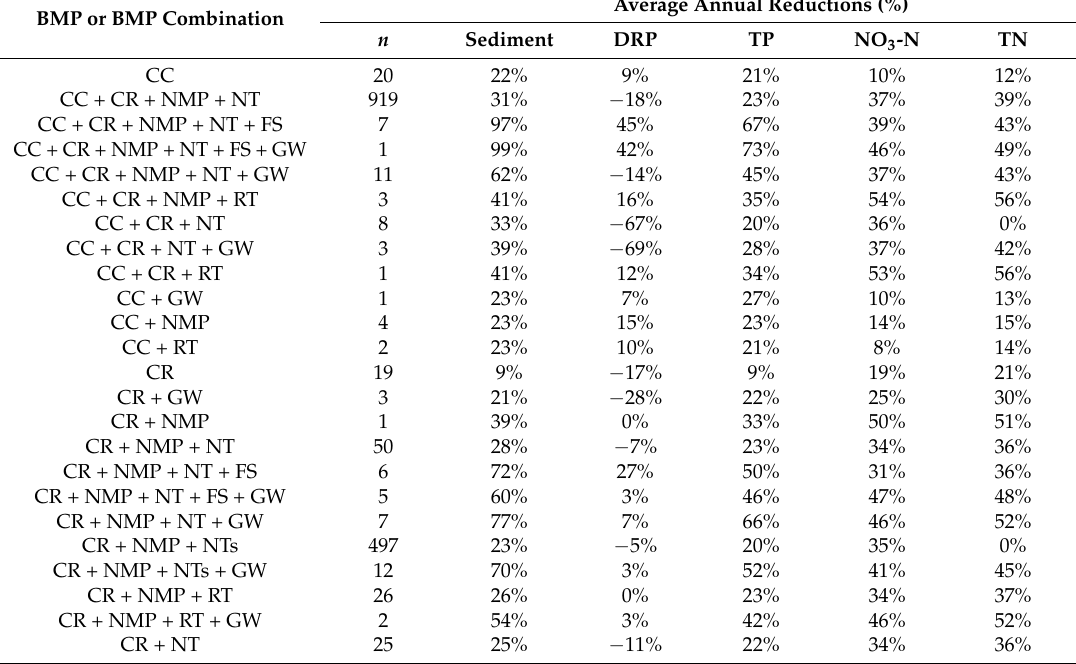
Table 8. Average annual reductions in sediment and nutrient loadings by BMP or BMP combination with the Eagle Creek watershed, Ohio SWAT model. Negative values indicate an increase in sediment or